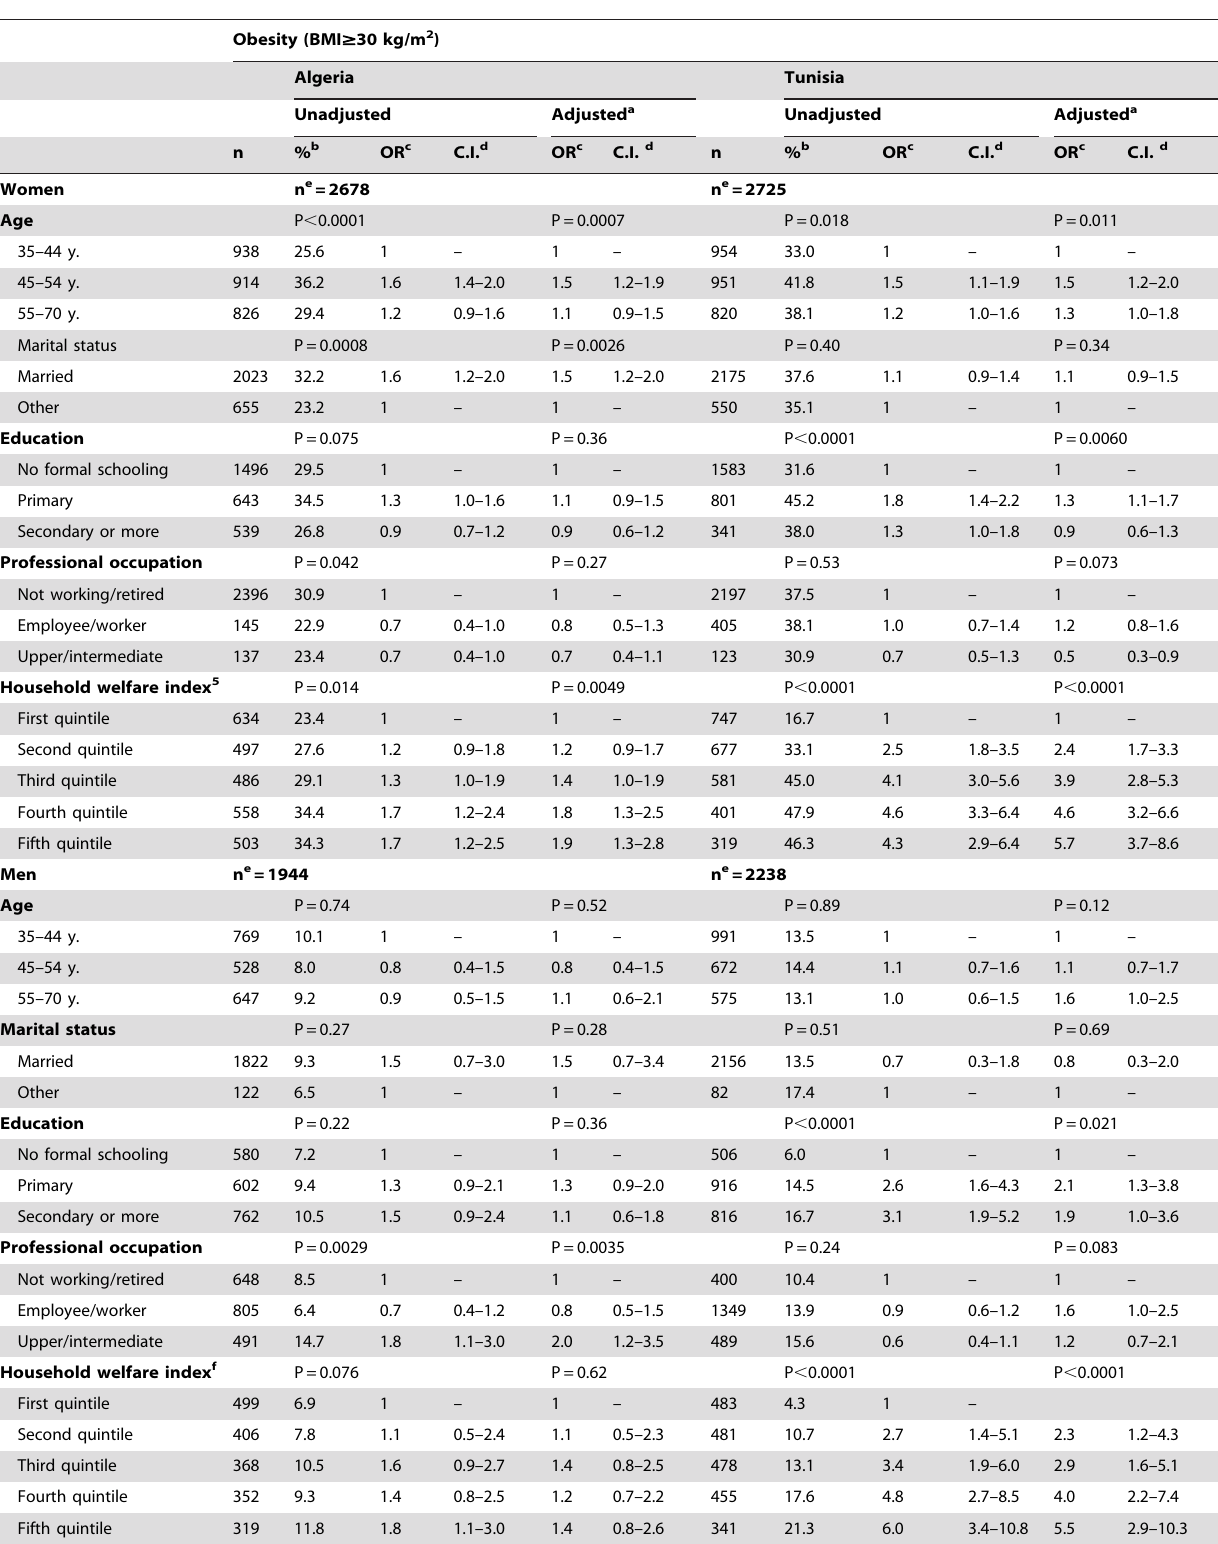
Table 3. Association of obesity with socio-economic factors, among 35–70 year old Algerians and Tunisians, by